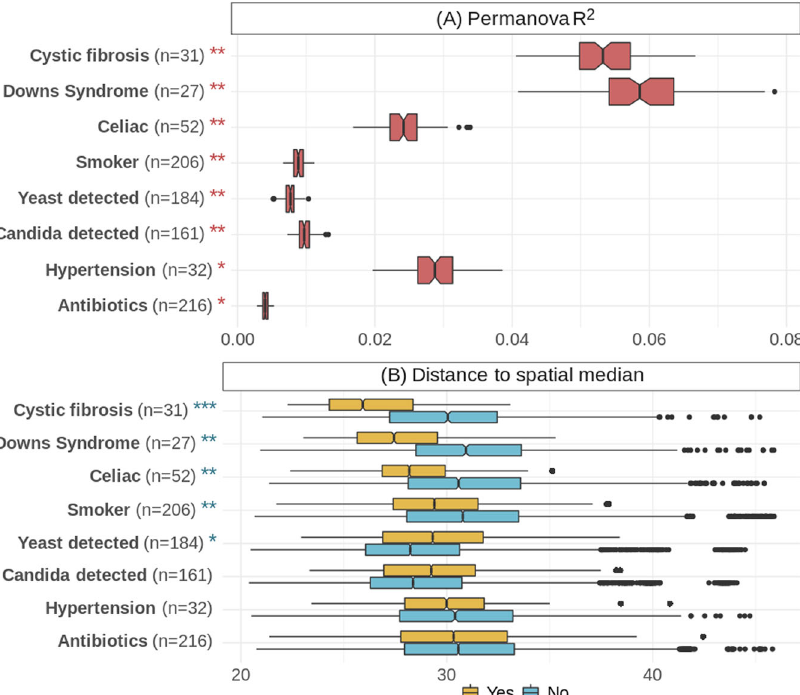
Fig. 2 Homogeneity and distinction of composition across variables. A Boxes show the distribution of R 2 values (the proportion of sum of squares from the total) from the PERMANOVA tests comparing groups of a given variable for the 100 subsamples. B Boxes represent the distances of each sample from the spatial median of its group (Yes in yellow, No in blue), as calculated by the betadisper function. The spatial medians for groups and the associated ANOVAs were run separately for each of the 100 subsamples, but the boxes here display all such distances for each group. Pairs of boxes in both plots are ordered by the absolute value of the difference between the pairs. The n in both plots indicates the number of samples for which a given variable was indicated (the same number of matched controls were selected for each subsample test). Red stars in ( A ) and blue stars in ( B ) indicate the magnitude of the mean adjusted p -values for the PERMANOVA tests and the ANOVAs of the betadisper tests, respectively. The representation of p -values are as follows: 0 “ *** ” 0.001 “ ** ” 0.01 “ * ” 0.05, Not signi fi